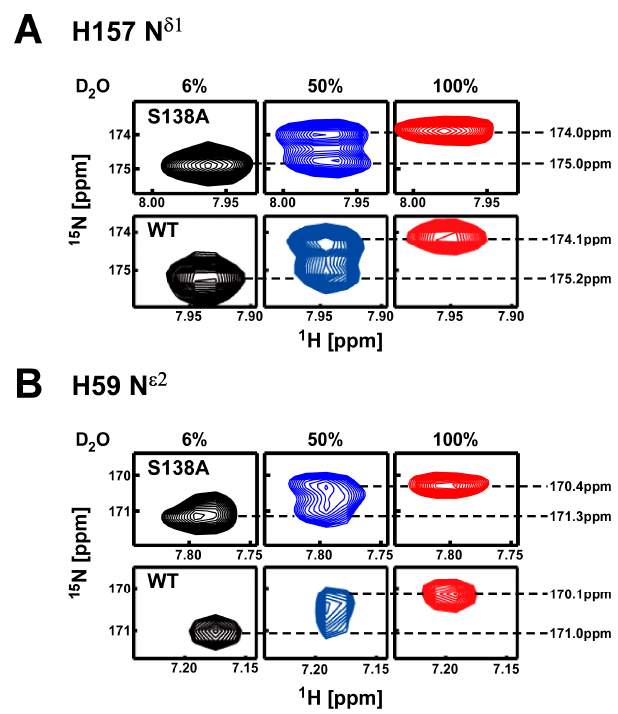
Figure 8. H/D isotope effects on the chemical shifts for 15 N nuclei in histidine imidazole rings for the S138A Pin1-PPIase mutant were measured in solutions with different D 2 O contents. The spectra for the S138A mutant are compared with those of the wild-type reported previously [13]. ( A ) 2D 1 H– 15 N δ 1 hetero-nuclear single quantum coherence (HSQC) signals for H157 collected in solutions containing 6% (black, left), 50% (blue, middle) and 100% D 2 O (red, right); ( B ) Same data set for 2D 1 H– 15 N ε 2 signals of H59. In each data, upper panel is for the S138A mutant and the lower is for the wild-type shown for comparison [13].